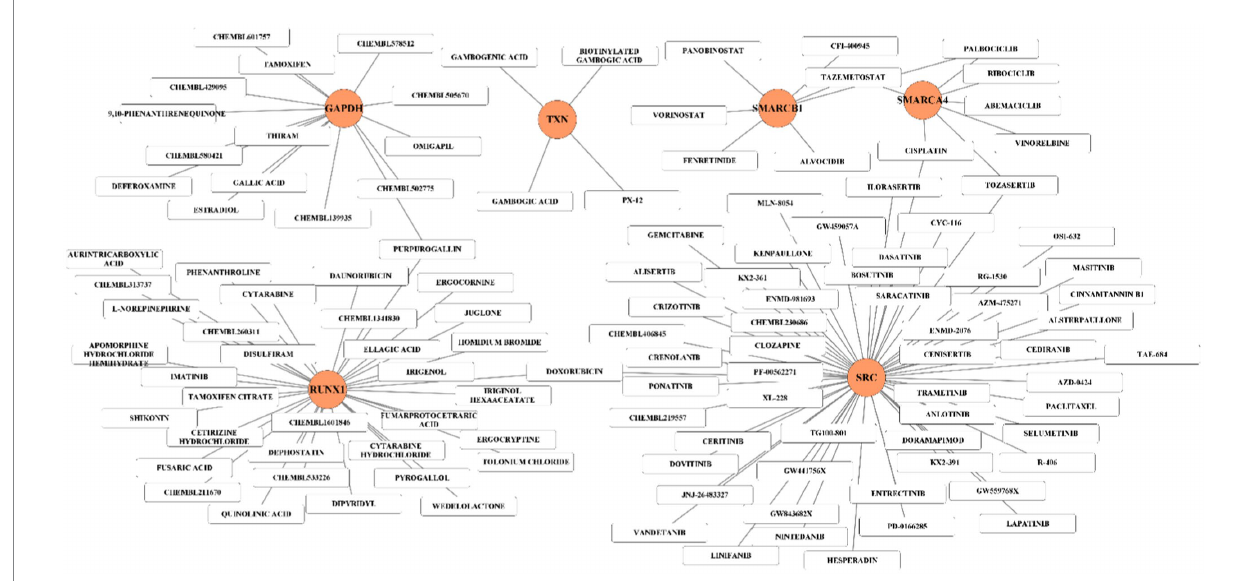
FIGURE 9 Hub gene-drug interaction network. The orange circles represent hub-gene and white rectangles represent small molecule drugs.